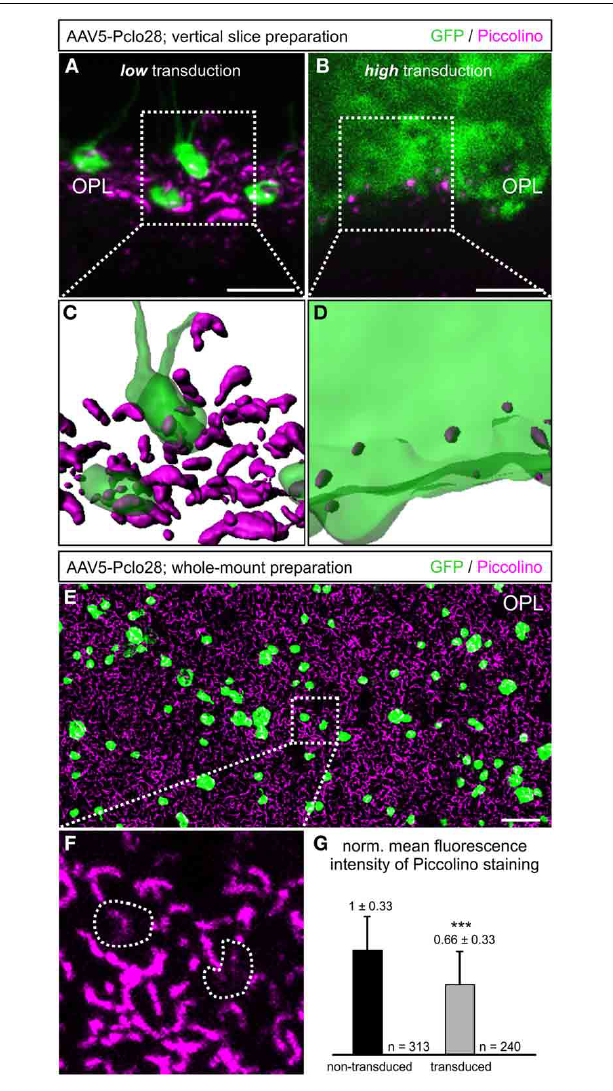
FIGURE 2 | Piccolino knockdown efficiency in rod photoreceptor terminals. (A,B) Staining of GFP (green) and Piccolino (magenta; antibody Pclo44a) in vertical cryostat sections through retinal areas with low (A) and high (B) AAV5-Pclo28-transduction rates 8w p.i. (C,D) 3D reconstructions of the GFP and Piccolino staining of the boxed regions in (A) and (B) . (E) Staining of GFP (green) and Piccolino (magenta; antibody Pclo44a) in an AAV5-Pclo28-transduced whole-mounted retina 8w p.i. Projection of a confocal image stack through the outer plexiform layer (OPL). (F) Higher magnification of the boxed region in (E) . GFP positive rod spherules are outlined with dotted lines. (G) Quantification of Piccolino fluorescence staining intensity in non-transduced vs. AAV5-Pclo28-transduced rod photoreceptor terminals. Bars show the mean fluorescence intensity ± SD normalized to non-transduced terminals ( ∗∗∗ p < 0 . 001; t -test). Scale bar in (A,B) : 5 μ m, in (E) : 10 μ